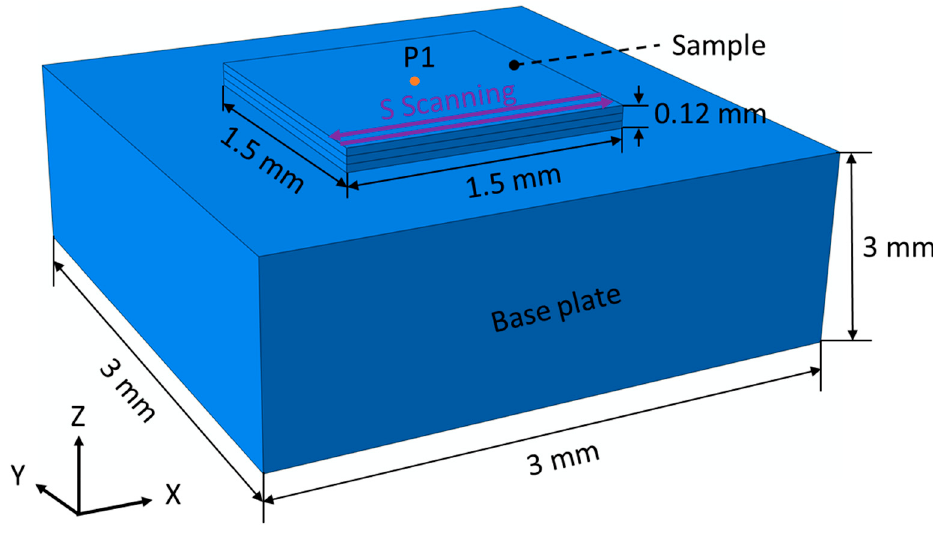
Figure 1. Model configurations.